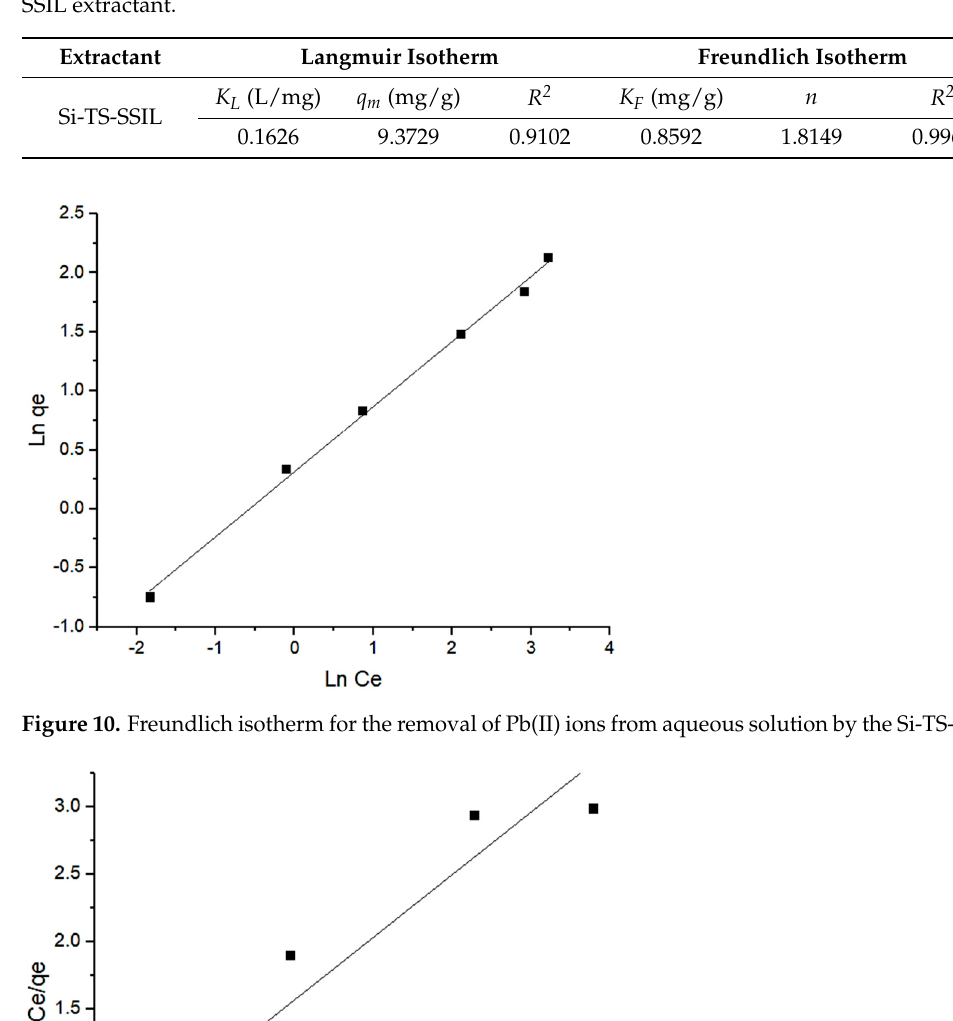
Figure 11. Freundlich isotherm for the removal of Pb(II) ions from aqueous solution by the Si-TS- SSIL. 2.5. Adsorption Mechanism For the adsorption mechanism using Si-TS-SSIL, the electron donors coming from the hydroxyl group, and the oxygen and sulphur of the thiosalicylate functional group in Si- TS-SSIL could be responsible for the chemisorption of Pb(II) ions. In addition to this, the organic and inorganic constituents’ presence in the Si-TS-SSIL extractant offered more ac- tive sites to bind with Pb(II) ions in the aqueous solution [39]. Additionally, Pb(II) ions would have been trapped in the pores of Si-TS-SSIL, which could contribute to the re- moval efficiency. Therefore, greater removal efficiency of Pb(II) ions by Si-TS-SSIL could be caused by the thiol functional group existing on Si-TS-SSIL extractant surface for bind- ing.